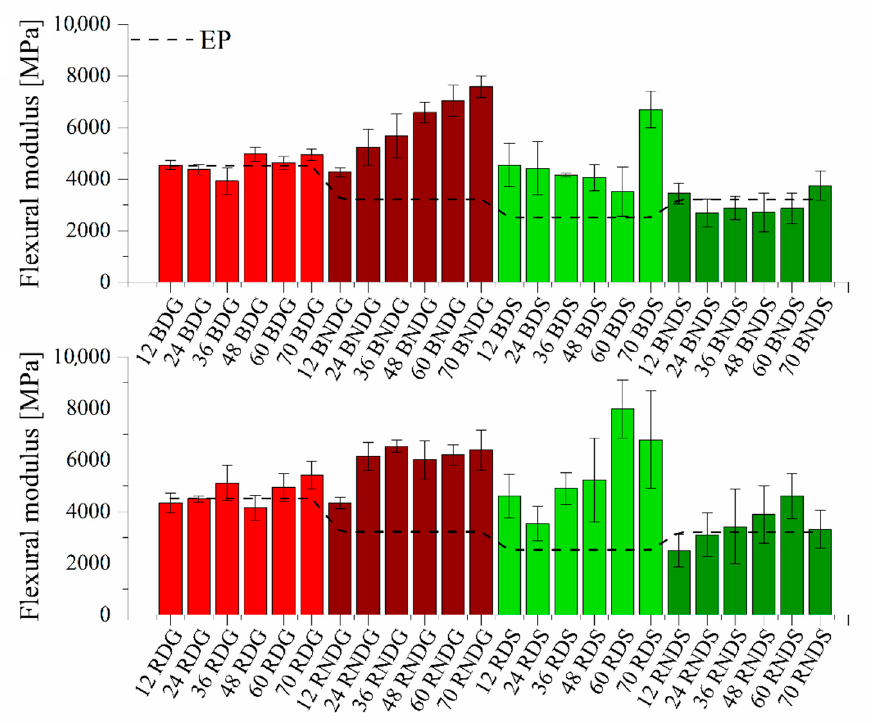
Figure 13. Flexural modulus for degassed and non-degassed composites containing base diatoms and rinsed diatoms.